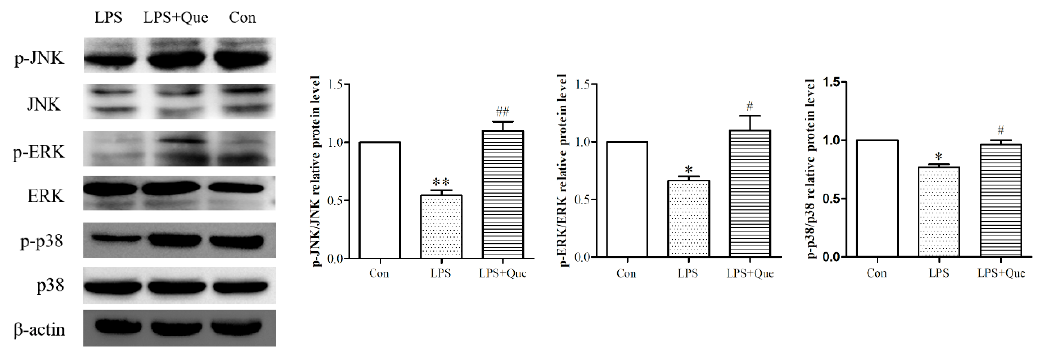
Figure 4. The effects of quercetin on total and phosphorylated levels of ERK and JNK. Total and phosphorylated levels of ERK, JNK, and p38 in different groups measured by Western blot. Values are shown as mean ± SEM. ** p < 0.01 or * p < 0.05 compared with the Con group. ## p < 0.01 or # p < 0.05 compared with the LPS group.